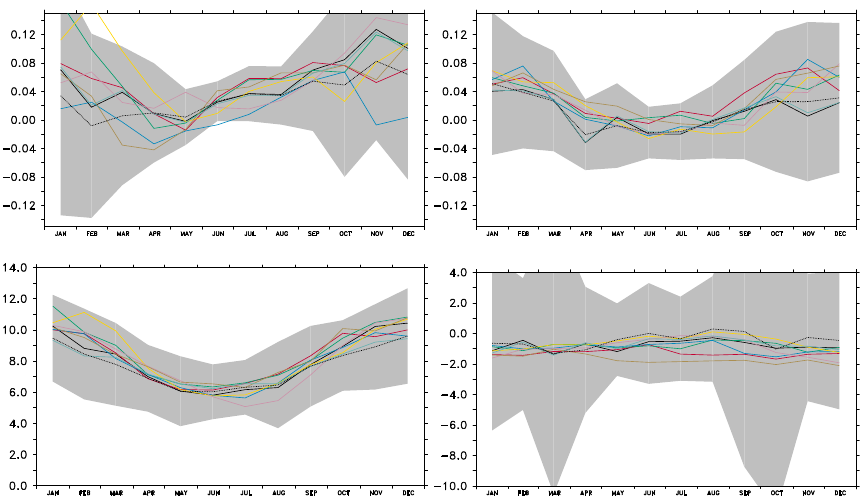
Figure 5. Climatological seasonal cycles averaged over the North Sea for zonal ( upper left ) and meridional ( upper right ) wind stress (N/m 2 ), wind speed (m/s) ( lower left ), and evaporation minus precipitation (10 − 5 kg/(m 2 s)) ( lower right ) for different RCA4-NEMO experiments during period 1970 to 1989. The line types and colors are the same as in Figure